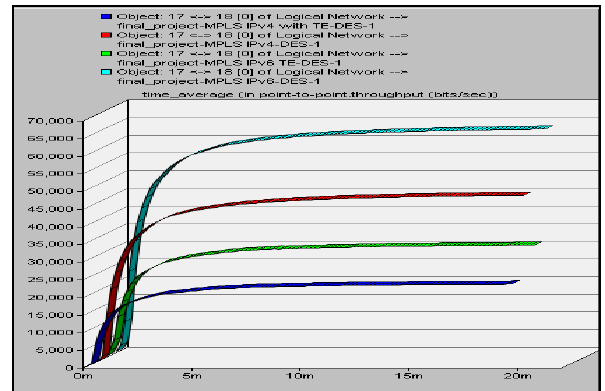
Figure 9 Throughput Comparison of IPv4 and IPv6 over MPLS and MPLS-TE along 17 to 18